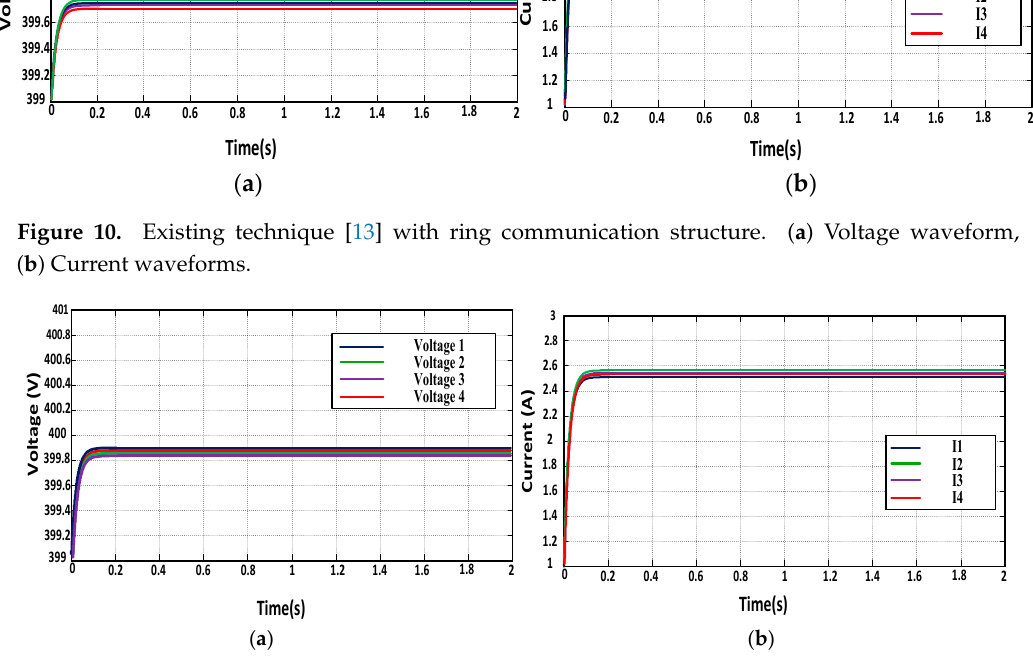
Figure 11. Proposed technique [12] with ring communication structure. ( a ) Voltage waveform, ( b ) Current waveforms.